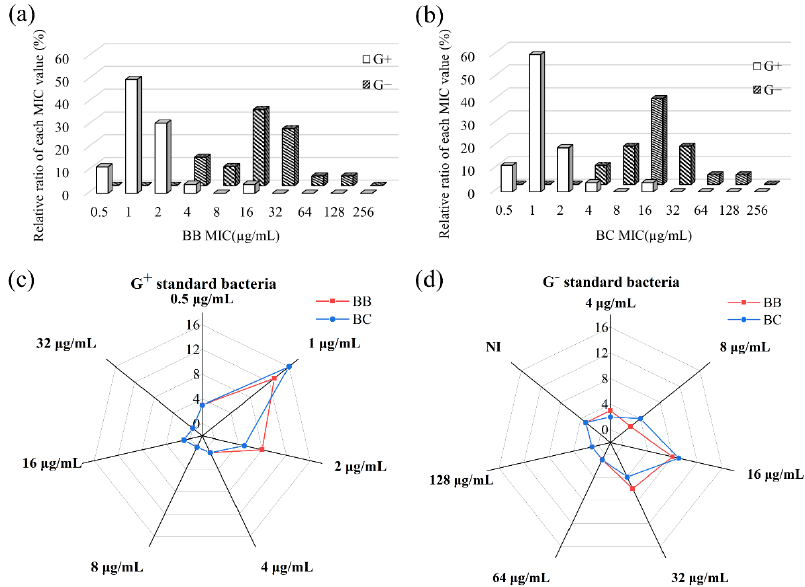
Figure 1. Inhibitory activity of brevilaterins against 50 species of standard bacteria. ( a , b ) the distri- bution of minimal inhibitory concentration (MIC) values of brevilaterin B (BB) and brevilaterin C (BC) against all standard bacteria; ( c , d ) comparison of MIC value distribution of brevilaterin B and brevilaterin C against Gram-positive bacteria ( c ) and Gram-negative bacteria ( d ), respectively. G + stands for Gram-positive. G − stands for Gram-negative, for convenience.